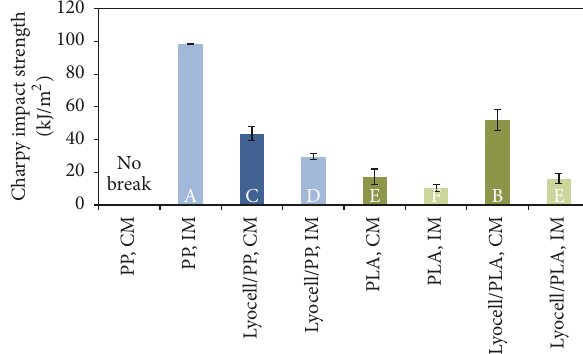
Figure 9: Unnotched Charpy impact strength of PP and PLA as well as their lyocell fiber-reinforced composites produced with CM and IM (mean value with standard deviation, different letters show significant differences; please note that either IM samples or CM samples should be compared with each other due to a different sample thickness of 4mm for IM samples and 2 mm for CM